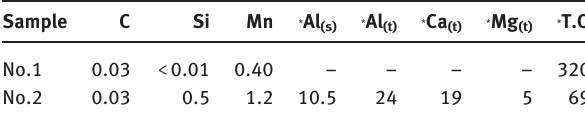
Table 2: Chemical composition of 304 stainless steel, (wt%, ﹡ ppm). Sample